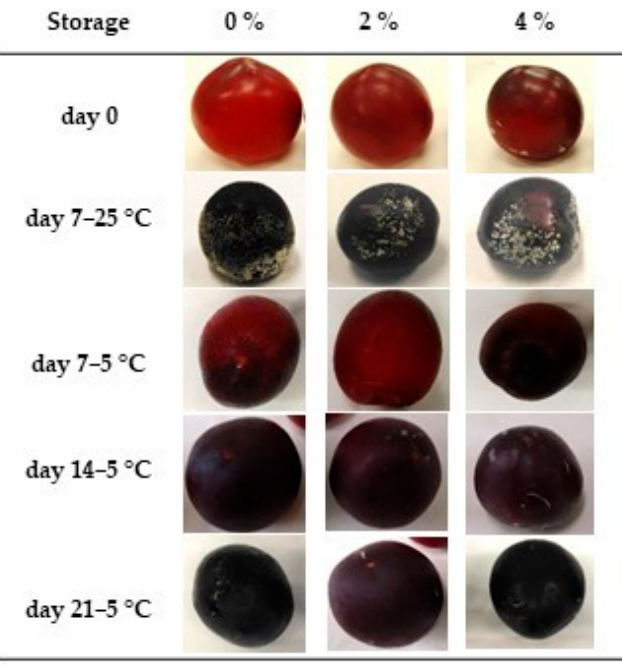
Figure 3. Images of plums with different concentrations (0, 2 and 4% mass/mass) of edible arrowroot starch coating stored at 25 °C and 5 °C.